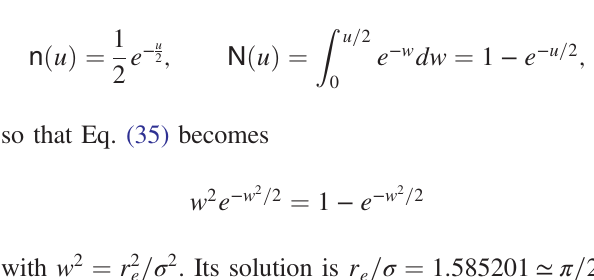
FIG. 13. The horizontal normalized force acting on an EDM (black) or MDM molecule (red), respectively, as a function of the transverse ð x; 0 Þ coordinate. The equilibrium position for the EDM case is indicated by the label r e . Note that for both types of dipole moment the force is discontinuous at x ¼ 0